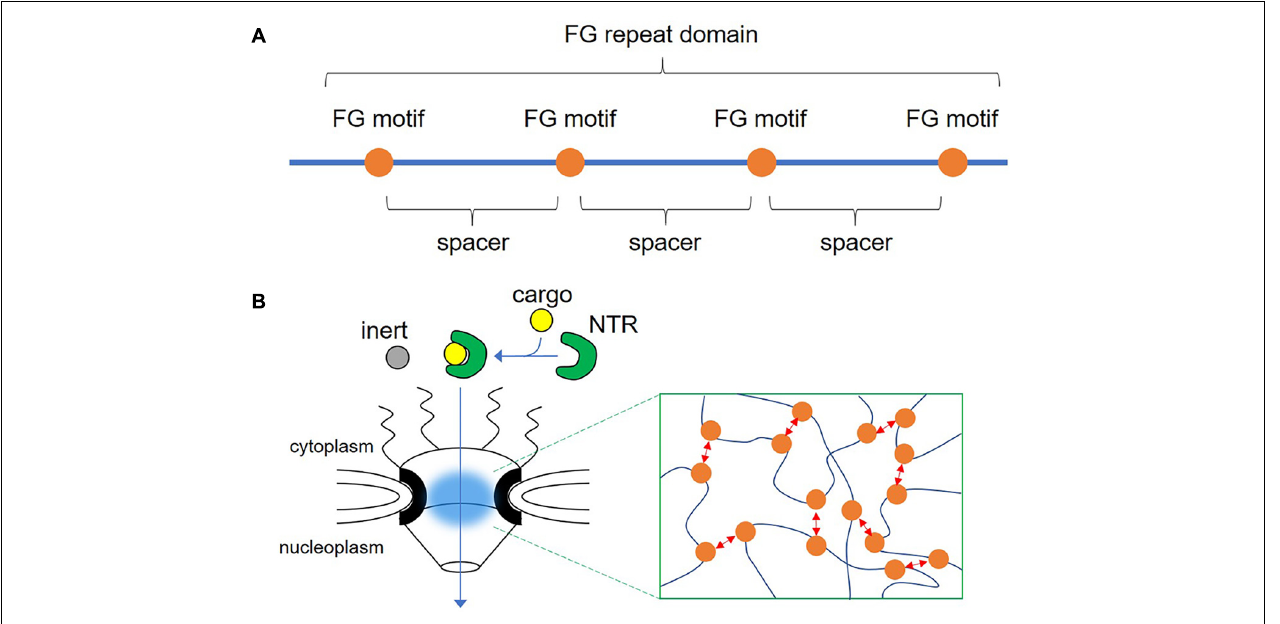
FIGURE 1 | Illustration of the phenylalanine-glycine (FG) repeat domain and the nuclear pore complex. (A) The FG repeat domain is composed of consecutive repeats of the FG motif (orange circle) and spacers, which lack a consensus sequence but are rich in serine and threonine residues. (B) Drawing of the nuclear pore complex indicating the transport of a nuclear transport receptor (NTR) and its cargo through the central channel composed of nucleoporins containing FG repeat domains (blue cloud). Inset shows dynamic multivalent interaction between FG motifs (red